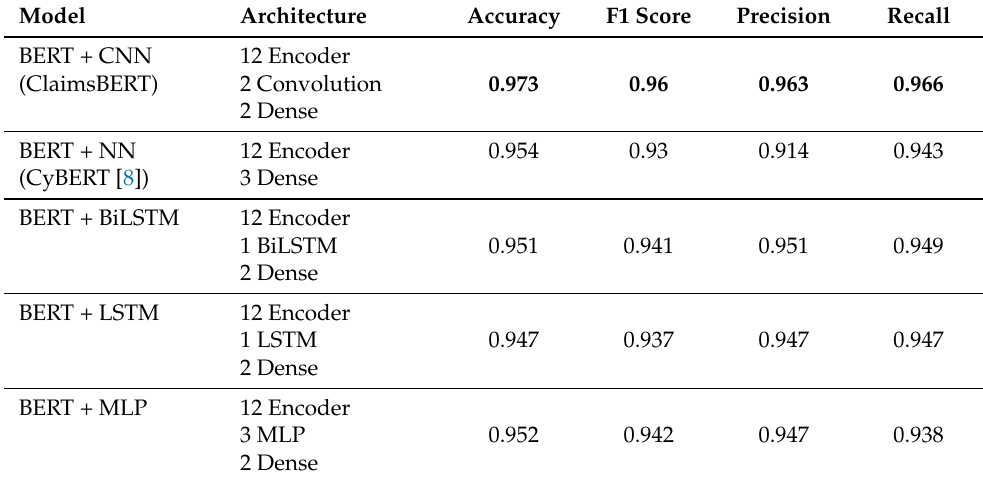
Table 6. Comparing classification performance of ClaimsBERT with other network-based models. The bold row indicates best model parameters with highest